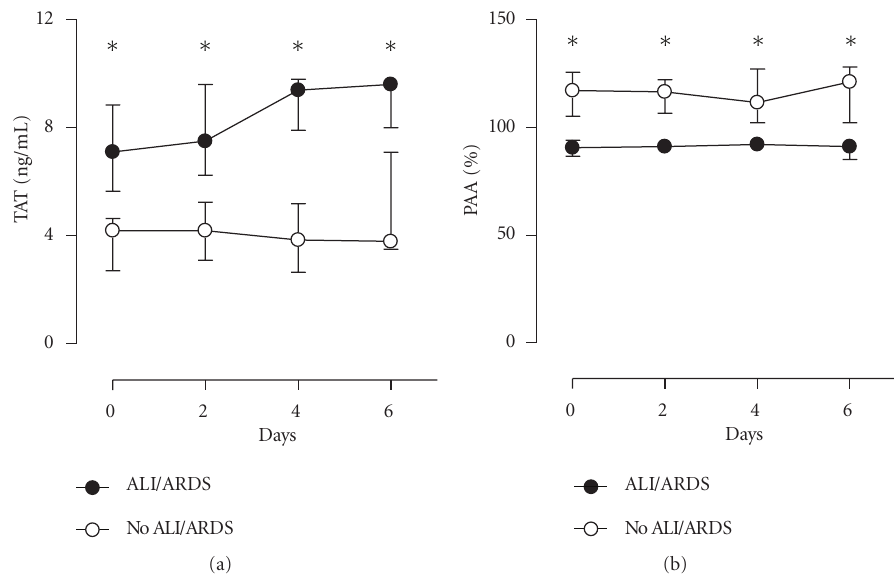
Figure 3: Systemic levels of coagulation and fibrinolysis. Thrombin-antithrombin (TATc) and plasminogen activator activity (PAA) in patients who developed VALI (closed symbols, n = 10), and patients who did not develop VALI (open symbols, n = 10). Data are medians ± IQR. ∗ , P < 0 .